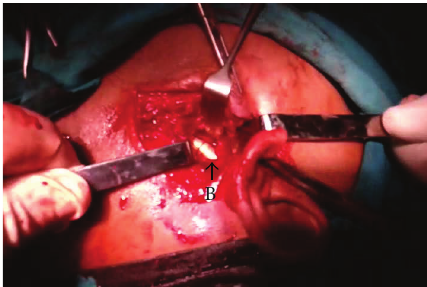
Figure6:Peroperativephotograph,showingthebullet(B)intheleft parapharyngeal space with its tip directed posterosuperiorly.